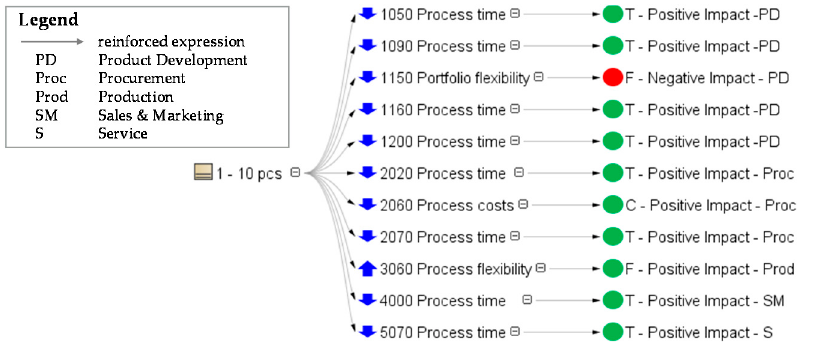
Figure 6. Partial relation map on the example of the boundary condition of the number of pieces.